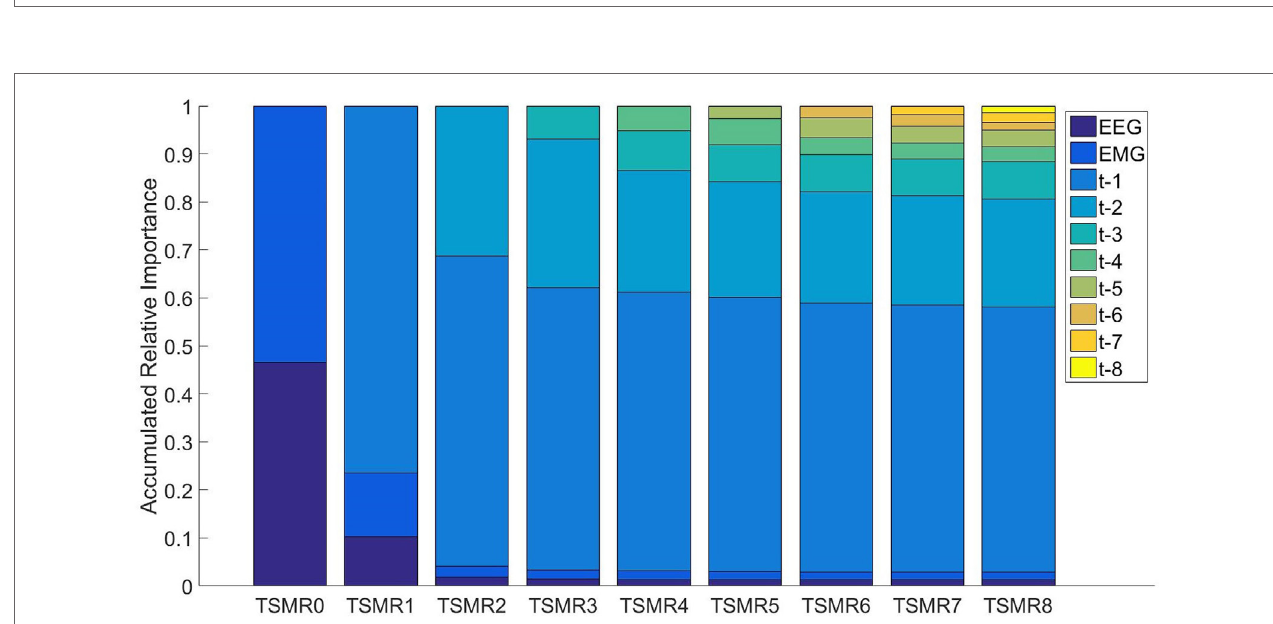
FigUre 5 | relative importance for each channel . Dark gray bars represent the results using Goh’s method. The light gray bars represent the Zero Substitution method. MG1, EMG2, EMG3, and EMG4 correspond to the upper trapezius , lower trapezius , deltoideus , and pectoralis major , respectively.